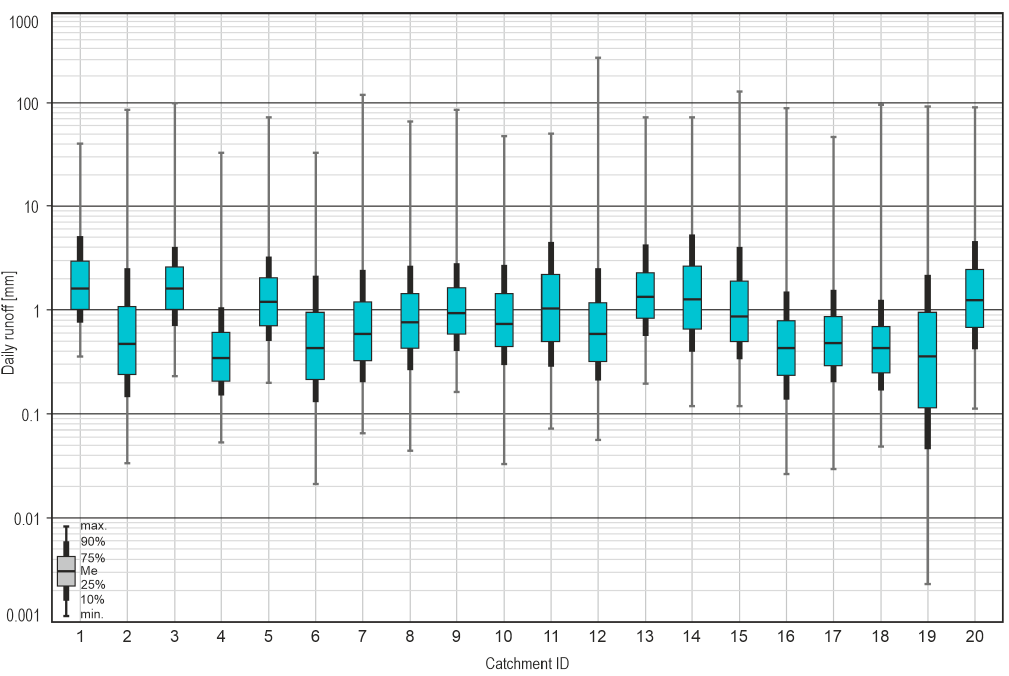
Figure 2. Distribution percentiles for daily runoff in the studied catchments in the period 1970–2019 (catchment ID nos. explained in Table 1).